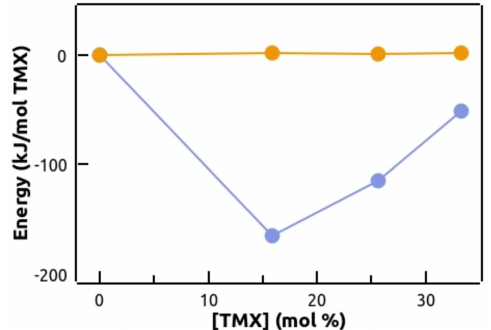
Figure 7. POPC-TMX electrostatic (orange) and hydrophobic (blue) energies of interaction in POPC membranes, as a function of TMX concentration (mol%). Error bars (representing the SD of the trajectories analyzed) are shown when bigger than the symbols.